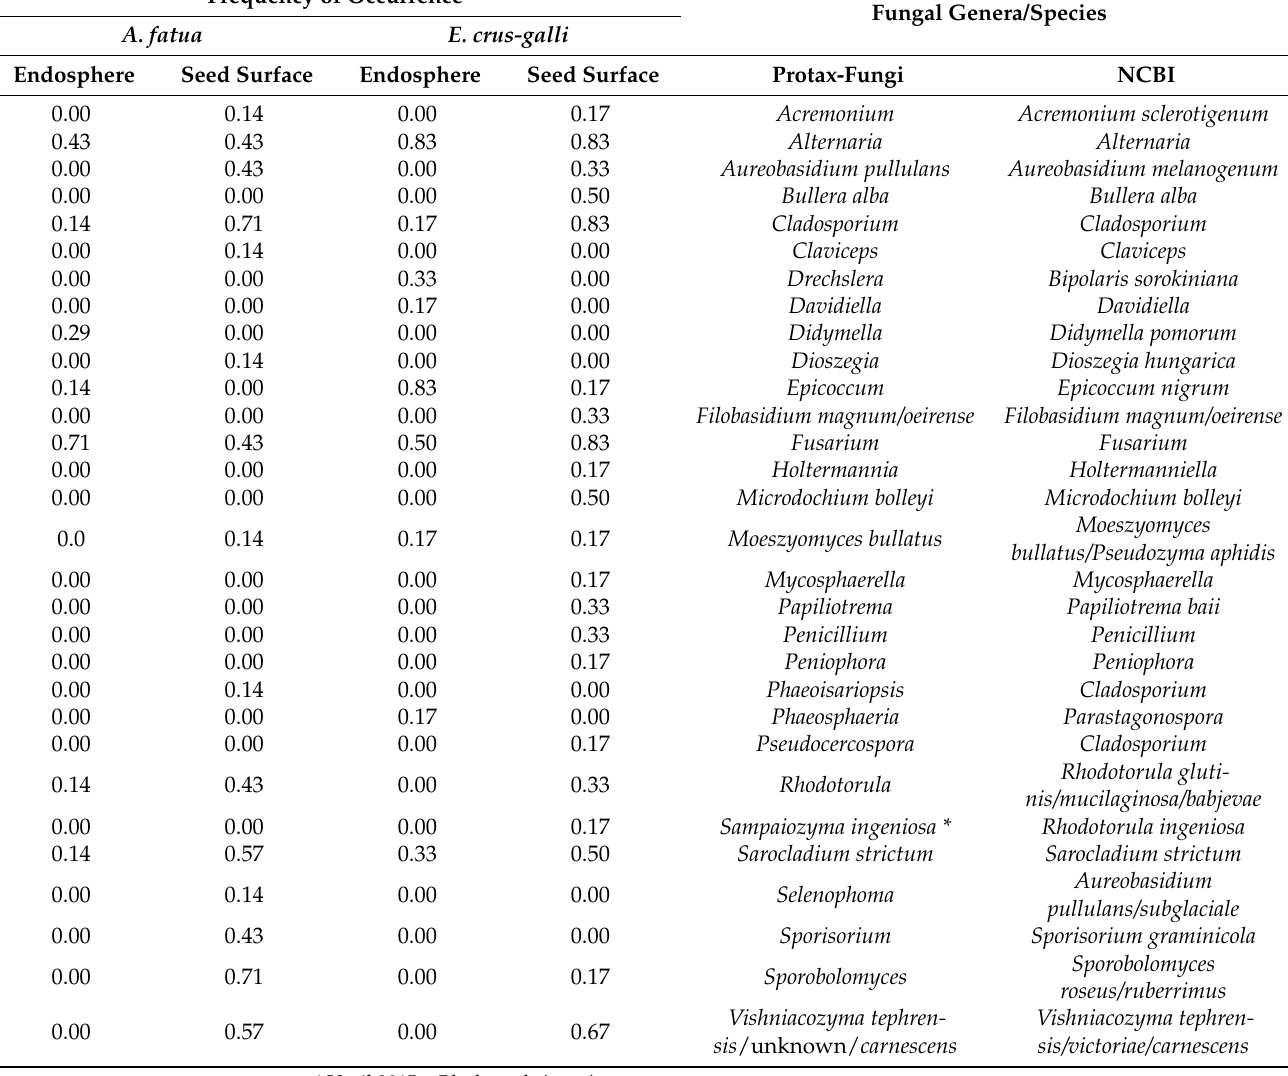
Table 2. Fungi isolated from A. fatua and E. crus-galli seeds and identified at the genus and species level using NCBI Blast search and Protax-fungi algorithm. No species is given where NCBI search resulted in multiple species with the same match for the query sequence. Frequency of occurrence was calculated as the summary incidence in seed samples from each species population in each year divided by the total number of seed samples, seven in A. fatua and six in E. crus-galli . A value of 1 means that the genus/species was isolated from each species population in both